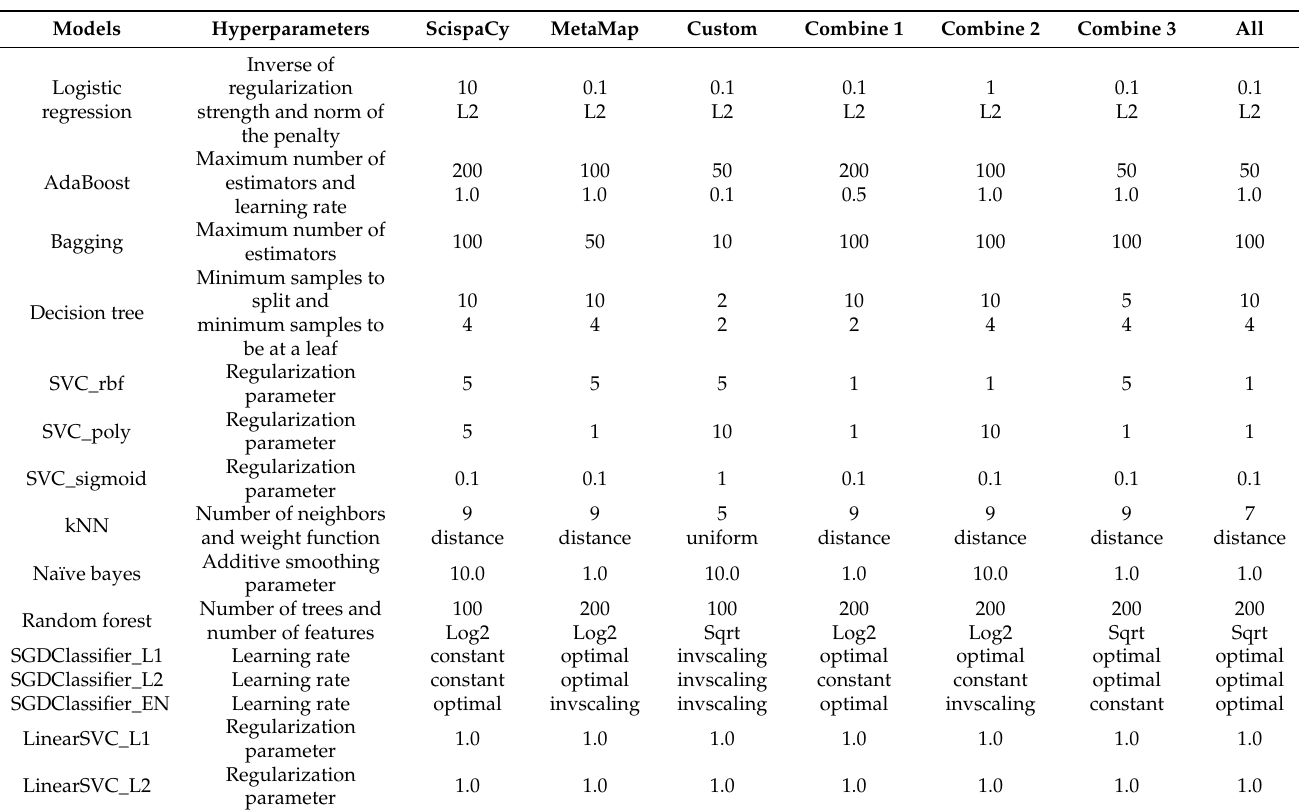
Table 3. Optimal hyperparameter combinations for BioIE-based features.